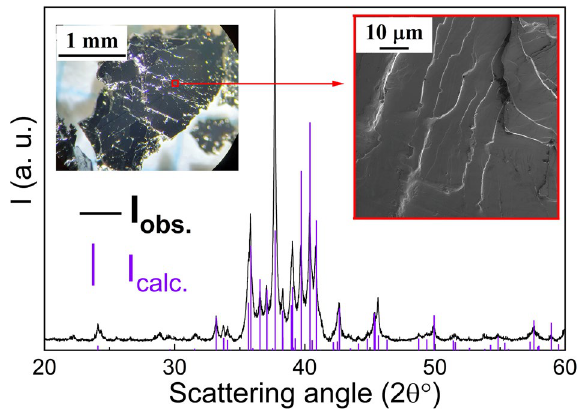
Figure 2. PXRD pattern of the GdAu 6.75−x Al 0.5+x title compound (I calc. refers to the calculated intensity based on the structure obtained from SC-XRD). Diffraction background and peaks from Cu–K α2 radiation have been subtracted from I obs. for clarity. The inset shows an optical photograph (left) and SEM image (right) of GdAu 6.75−x Al 0.5+x sample as it is obtained from synthesis; piles of sub-micron (< 1 µm) thick flakes, extended to large areas (mm 2 ) were observed.